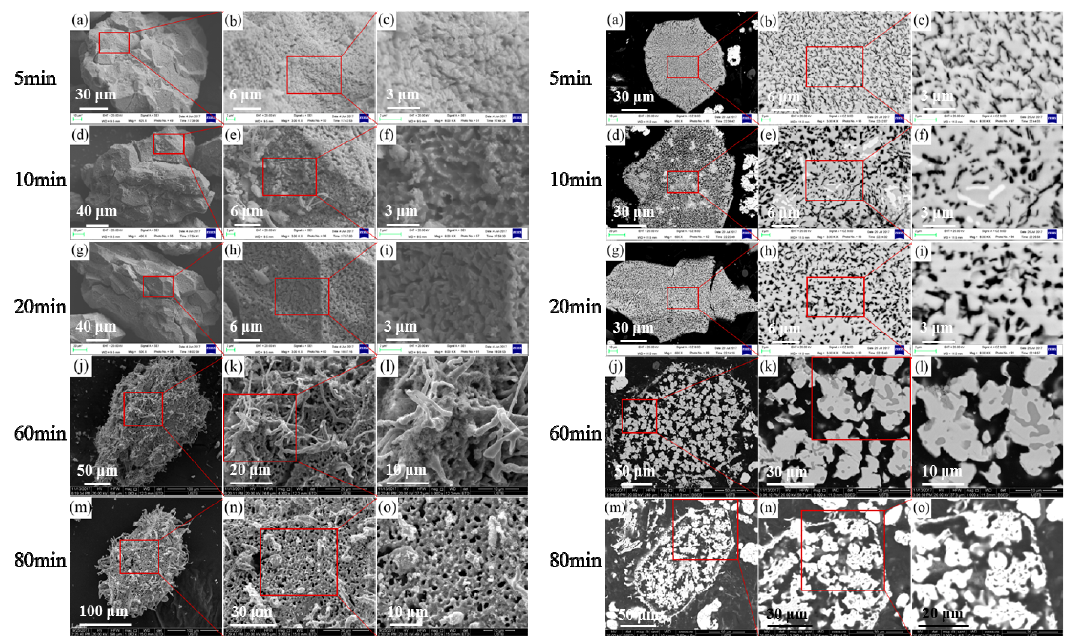
Figure 8. Microscopic observation of the particle surface morphology (left column) and the cross-section morphology (right column) of the iron ore particles after reduction at 973 K in 95% CO + 5% CO 2 atmosphere.